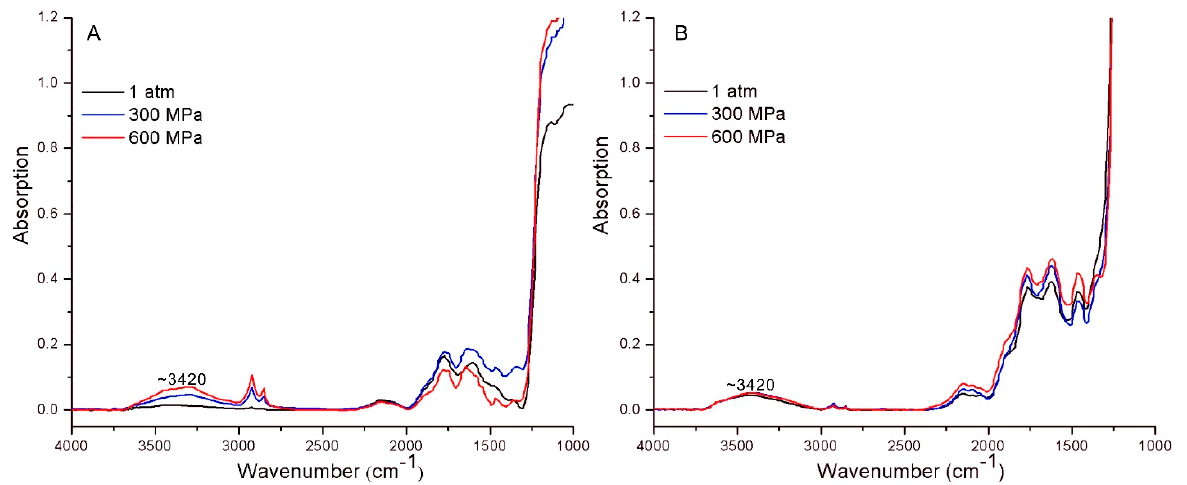
Figure 3. FTIR spectra of 300 and 600 MPa pressure: ( A ) colorless feldspar; ( B ) pink feldspar. The spectra are stacked for comparison. Table 3. FTIR spectra and analysis of two types of orthoclase at 300 and 600 MPa pressure.